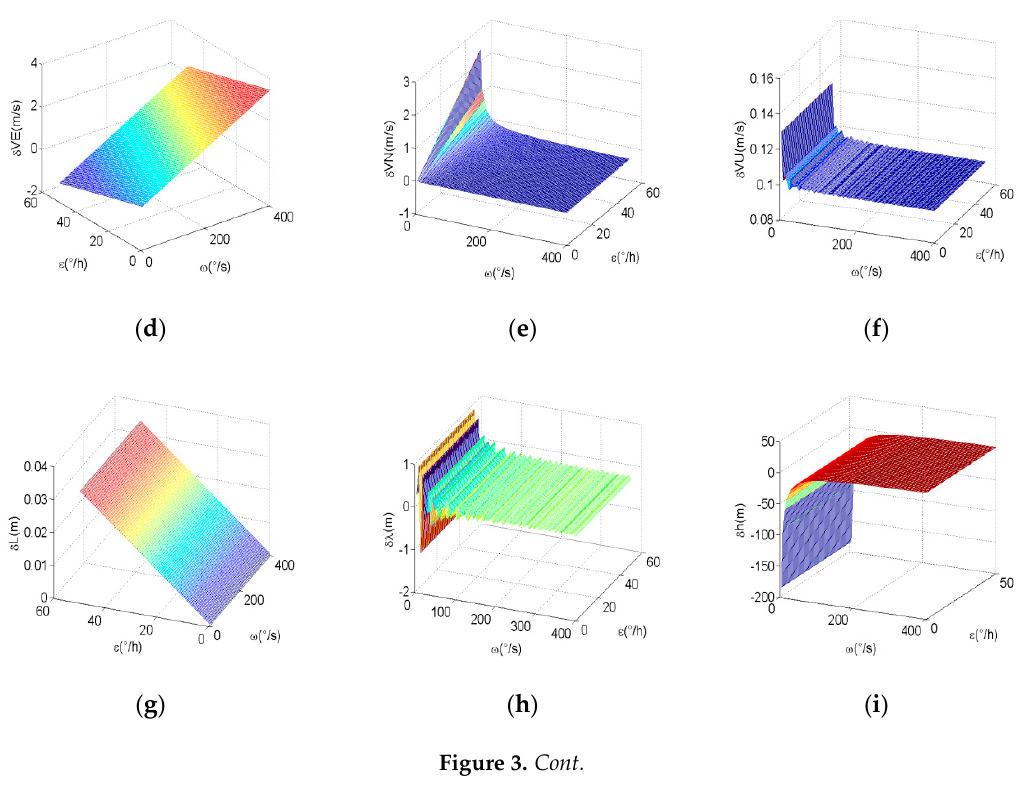
Figure 3. ( a – c ) The relationship curves of east, north, and up attitude errors with the constant bias of gyro and modulation angular rate, respectively. ( d – f ) The relationship curves of east, north, and up velocity errors with the constant bias of gyro and modulation angular rate, respectively. ( g – i ) The relationship curves of latitude, longitude and height errors with the constant bias of gyro and modulation angular rate,